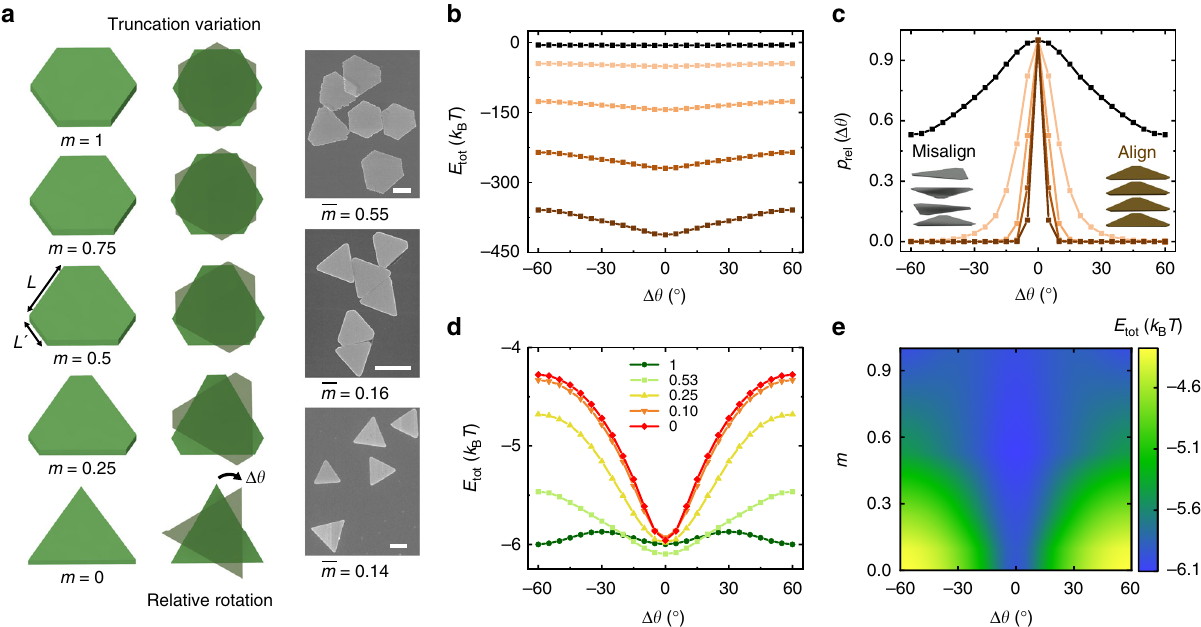
Fig. 3 The effective shape of columns modulated by ionic strength or plate tip truncation. a Schematics (left) and SEM images (right) showing plates of a systematically varying extent of truncation m (de fi ned as L ′ / L ). The top right SEM image shows the plates used in the hexagonal lattice. The corresponding truncation distributions are shown in Supplementary Fig. 13. Scale bars: 1 µ m. b A graph showing how the computed pairwise interaction E tot between two stacked plates ( m = L ′ = (cid:1) L = 0.53, corresponding to the plates used for hexagonal lattice) changes as a function of Δ θ at different ionic strengths (from top to bottom: 0.5, 1, 1.5, 2, and 2.5 mM, respectively). Note that 0.5 mM is used in the hexagonal lattice assembly. c Relative probability distributions of Δ θ based on a Boltzmann distribution argument at different ionic strengths, computed from the interaction energy plot in b (color coded the same as in b ). The inset schematics show misaligned plate orientations inside column (left) at low ionic strength (0.5 mM) and well-aligned plate orientations (right) at high ionic strength (2.5 mM). d A graph showing how the computed pairwise interaction E tot between two stacked plates changes as a function of Δ θ at different extent of truncation m as labeled. Here the calculations are conducted at a fi xed basal plane area (3.27 µ m 2 ). Ionic strength: 0.5 mM. e Pairwise interaction strength as a function of Δ θ and truncation m at their energy minimum spacing d . Ionic strength: 0.5